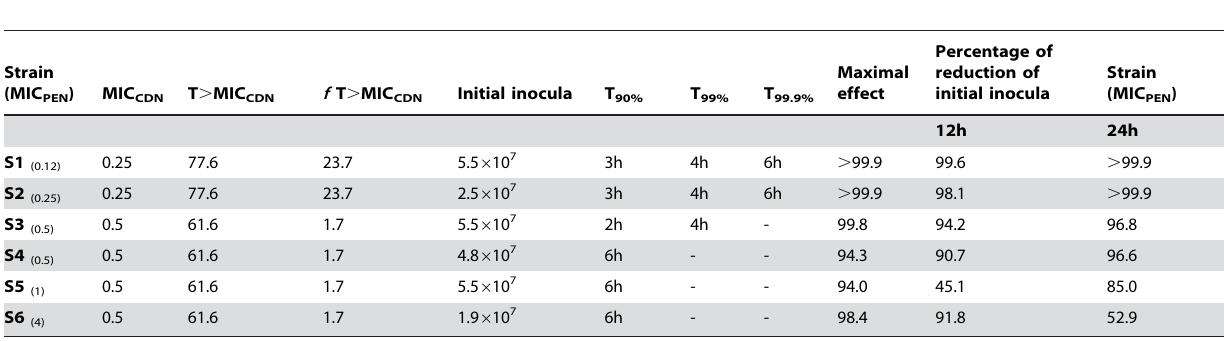
Table 1. Mean reduction of initial inocula: Time to obtain 90%, 99% and 99.9% reductions (T 90% , T 99% and T 99.9% ), maximal effect (maximal reduction in percentage within the dosing interval: 0-12h) and percentage of reduction at 12h and 24h.